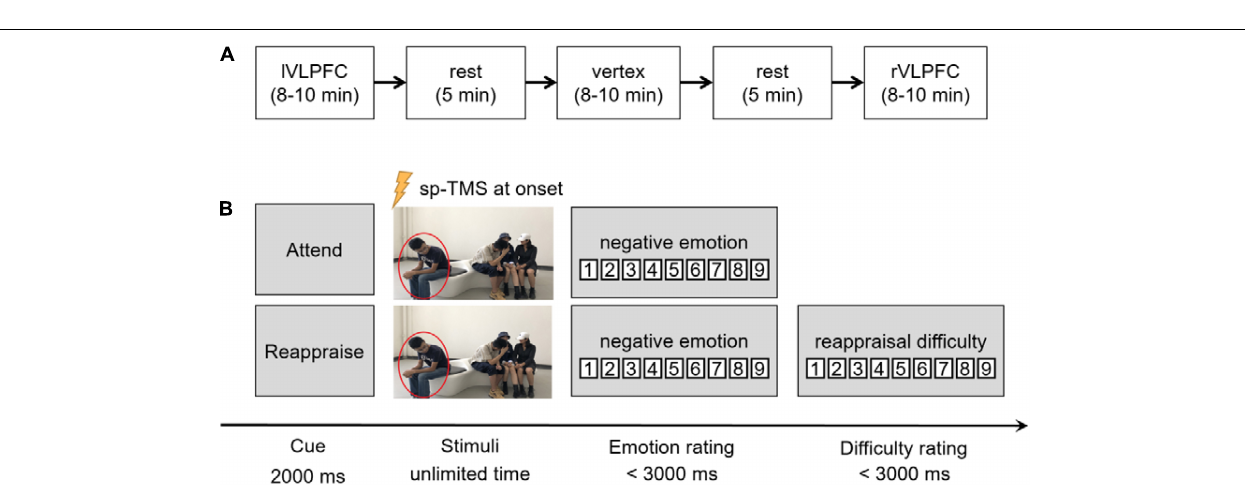
FIGURE 1 | Illustration of the transcranial magnetic stimulation (TMS) electric fields of the three TMS conditions. The color represents the electric field strength, scaling from 0 (blue) to individual maximum (red).